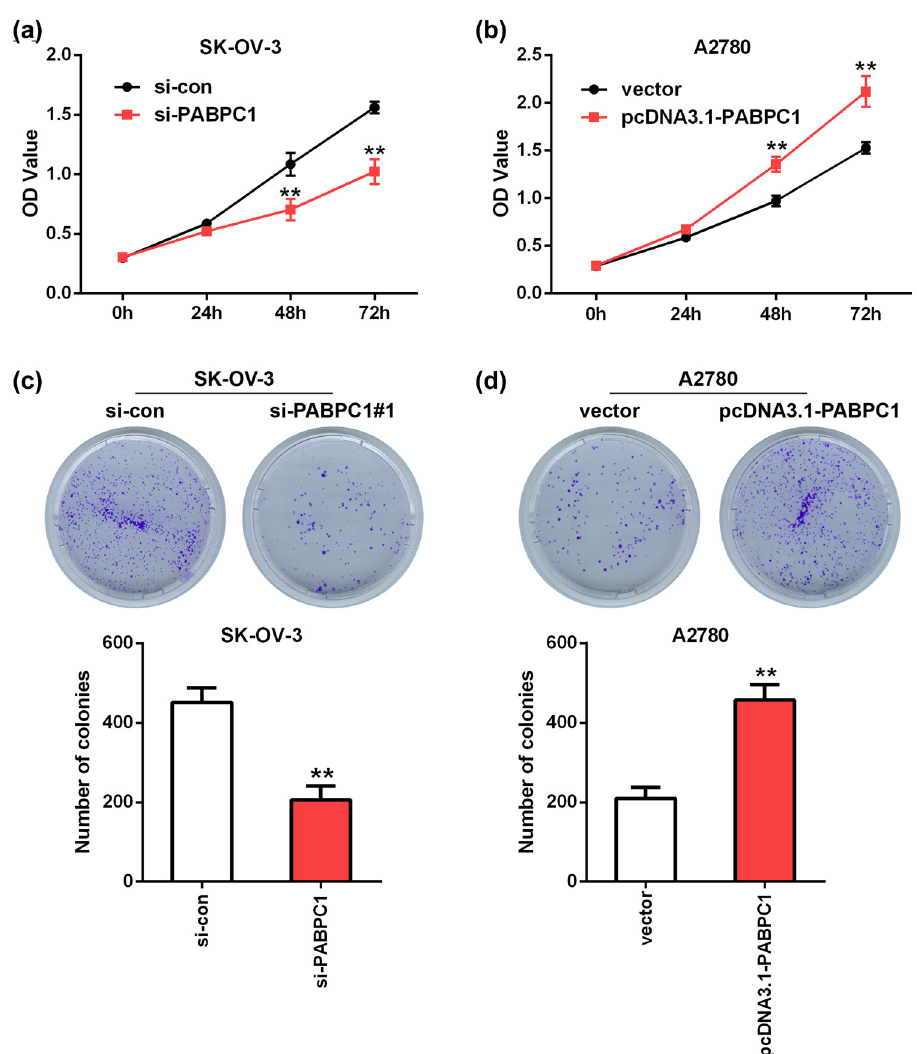
Figure 3: In fl uences of knockdown and overexpression of PABPC1 on proliferation. The SK - OV - 3 cells proliferative ( a ) and clonogenic ( c ) capacities were detected utilizing CCK - 8 ( a ) and clone formation ( c ) assays after depletion of PABPC1. The A2780 cells proliferative ( b ) and clonogenic ( d ) capacities were detected utilizing CCK - 8 ( b ) and clone formation ( d ) assays after upregulation of PABPC1. ** P < 0.01 vs si - con or vector